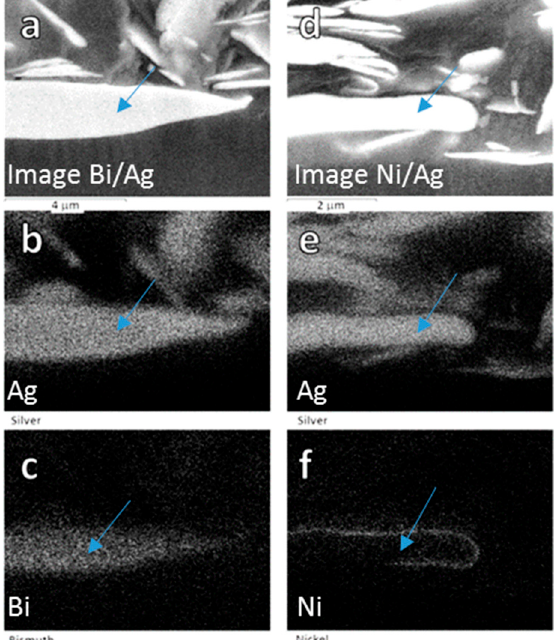
Figure 10. Cross section EDS maps of the dewetted and displaced “ridge” portion of ( a – c ) Bi-Ag layered films and ( d – f ) Ni-Ag layered films after the dewetting process described in the text. The EDS shows a contrast in the elemental distributions. A segregated displaced layer of Ni ( f ) is shown to encapsulate the displaced Ag shown in ( e ) during the dewetting process of the Ni / Ag films. This is in contrast to the mixed phase of Bi with Ag for the dewetted Bi / Ag films. The arrow indicates the dewetted and displaced metal “ridge”. The other Ag is from the conductive epoxy utilized for the specimen preparation.